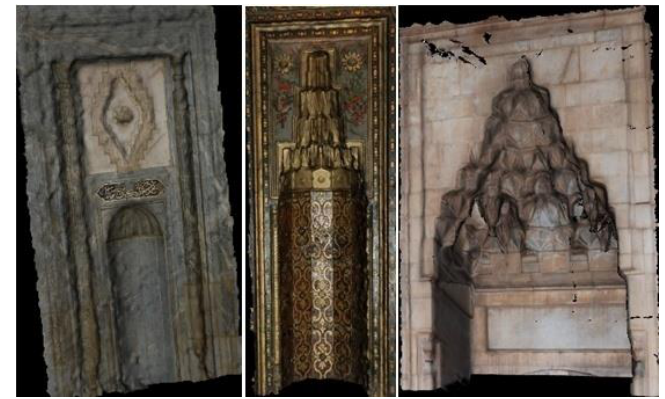
Figure 14. Texture mapped 3-D models of Mihrabs in Huzur-ı Pir section ( left , middle ) and the door of Masjid ( right ).